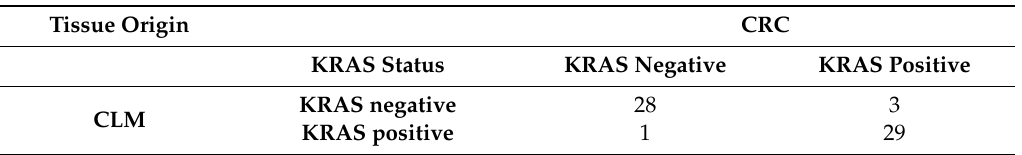
Table 1. The concordance between tissue KRAS status (KRAS positive vs. KRAS negative) in primary tumor (CRC) and liver metastases